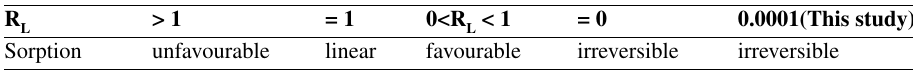
Table 4. The dimensionless separation factor.